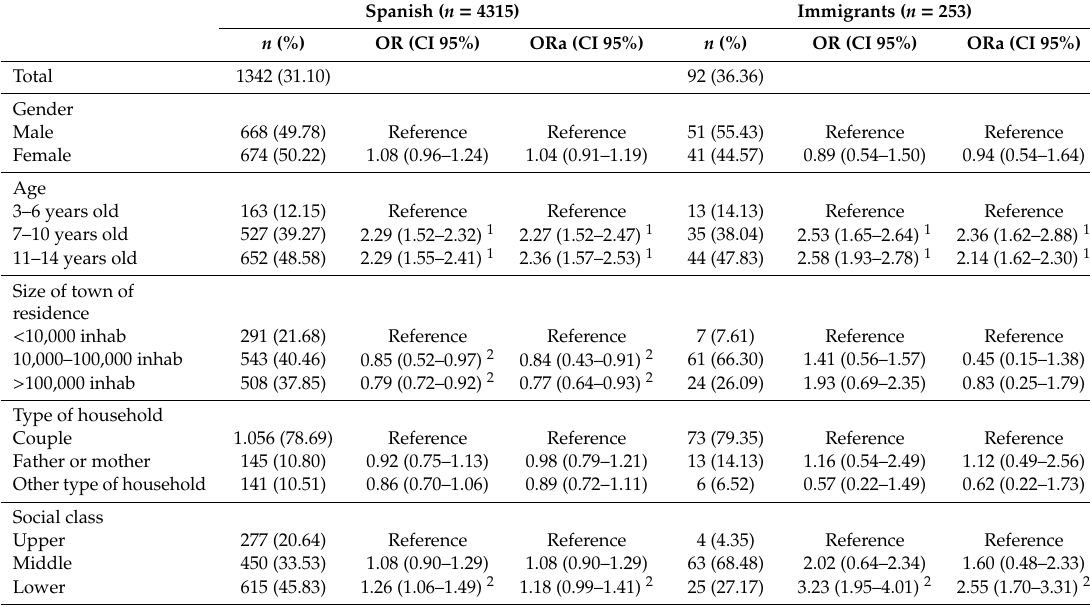
Table 3. Association between the presence of dental health problems and socioeconomic and demographic variables in Spanish and immigrant child-adolescent population. Spanish National Health Survey, 2017. Spanish ( n = 4315) Immigrants ( n =